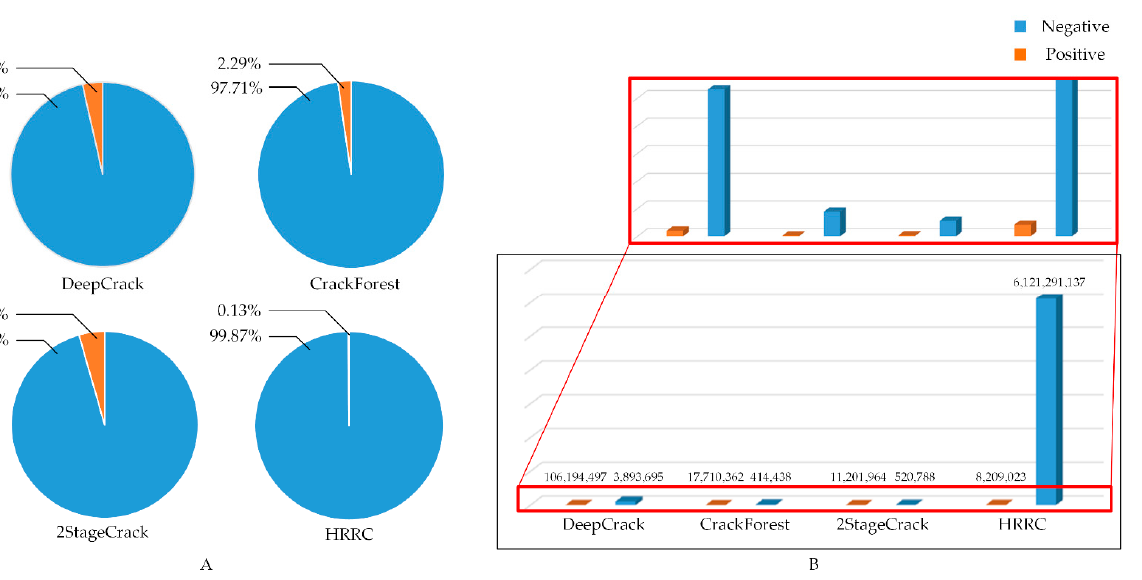
Figure 4. The total amount of data in each dataset, as well as their positive and negative sample ratios. ( A ) Positive and negative sample ratios. ( B ) Number of pixels in each